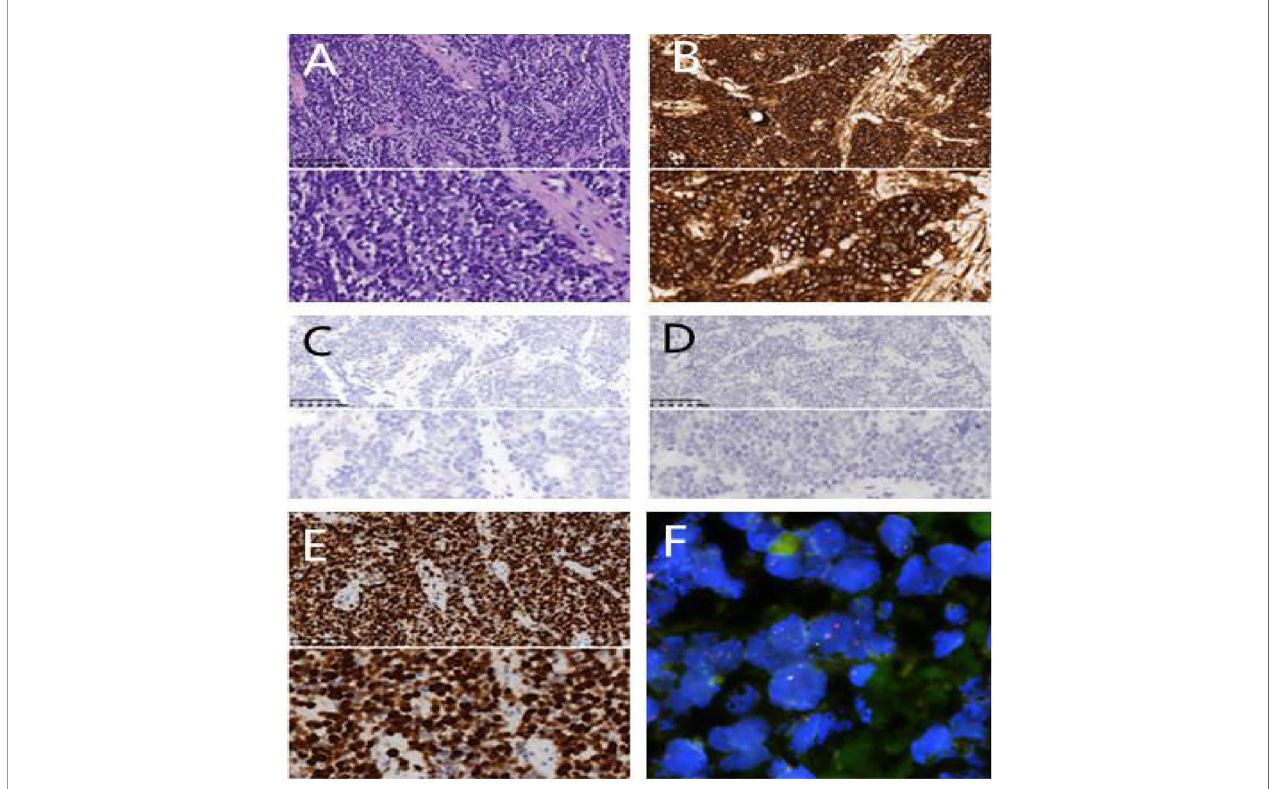
FIGURE 2 | Pathological examination. (A) H&E×200/400 cell block shows small round tumour cells; (B) CD99(+)×200/400; (C) AE1/AE3(-)×200/400 (D) TTF-1 (-)×200/400 (E) Ki67(appro. 80%+×400); (F) FISH shows EWSR1 gene rearrangement.